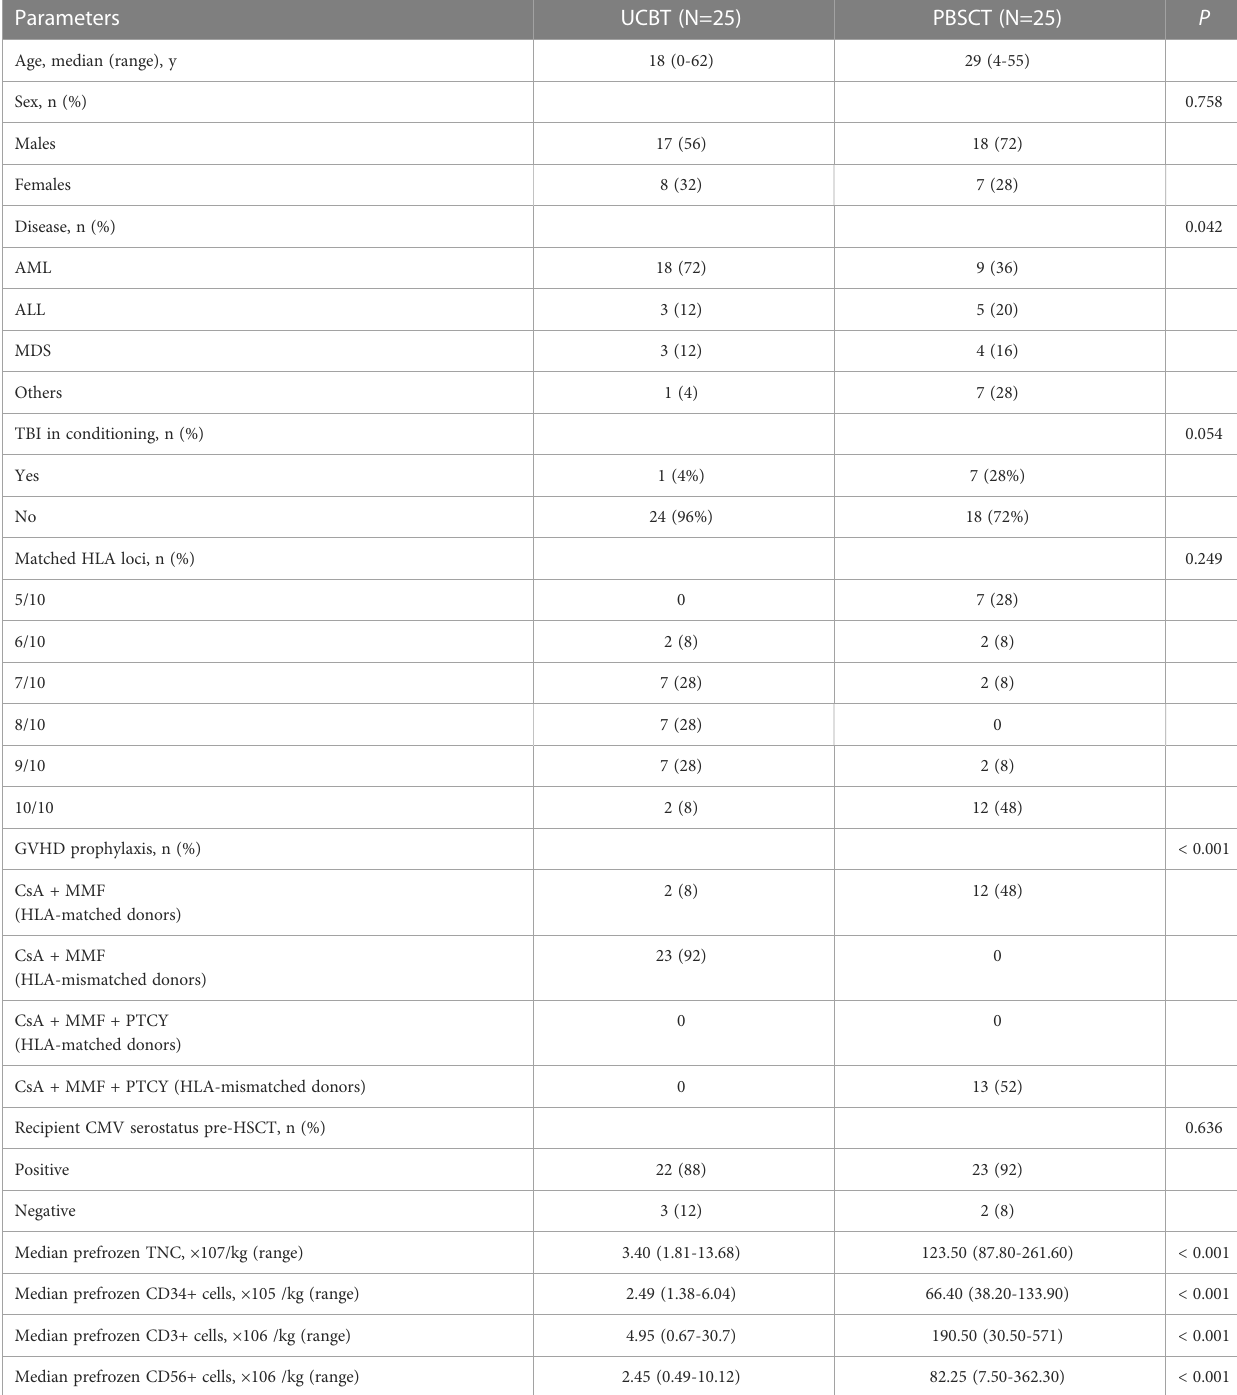
TABLE 1 Baseline characteristics of the study patients.